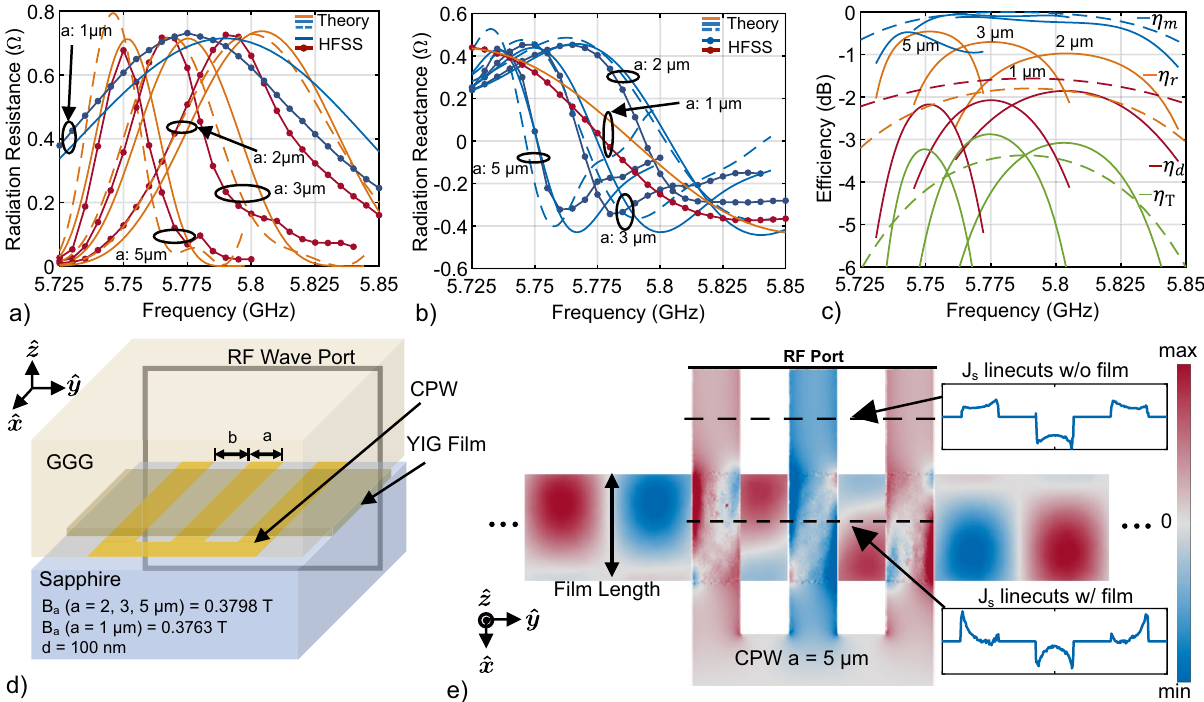
Figure 4. Summary of system performance for various short CPW transducers targeting the LTE-U band. ( a , b ) Radiation impedance for several CPW transducers of length 10 µ m and sizes a = 1, 2, 3, and 5 µ m covering part of the LTE-U band. Solid orange and blue curves are computed using the theoretical approach outlined in “Design methodology”. Markered red and dark blue lines are the radiation impedance obtained by the numerical approach outlined in “Design methodology”. Dashed orange and blue lines are computed by a modification of step 3 in the theoretical approach. The a = 1 µ m transducer is biased at B a = 0.3763 T while the other transducers are biased at B a = 0.3798 T. ( c ) The radiation efficiency ( η r ), match efficiency ( η m ) and dissipation efficiency ( η d ), and total transducer efficiency ( η T ). Dashed curves represent a = 1 µ m efficiencies. Network dimensions are given in Table 1. ( d ) FEM simulation setup of a YIG-on-GGG flip-chipped onto a CPW transducer with a sapphire substrate. ( e ) Top view of the CPW J s and spin wave amplitude H x . Insets are 1D line-cuts of J s